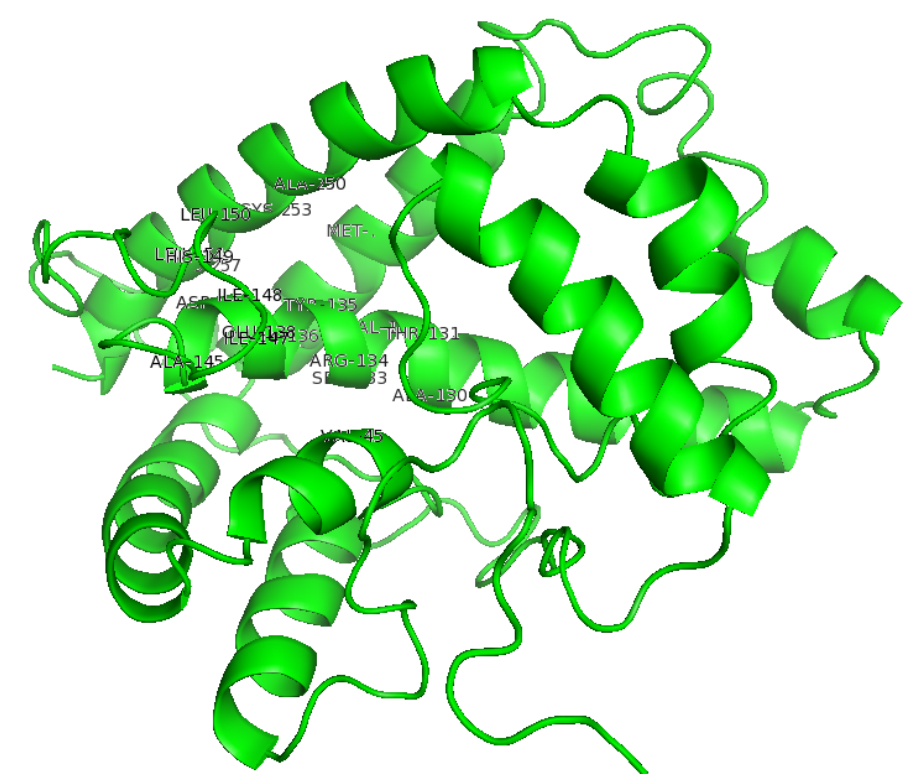
Figure 10. The structure of DehD showing active site amino acid